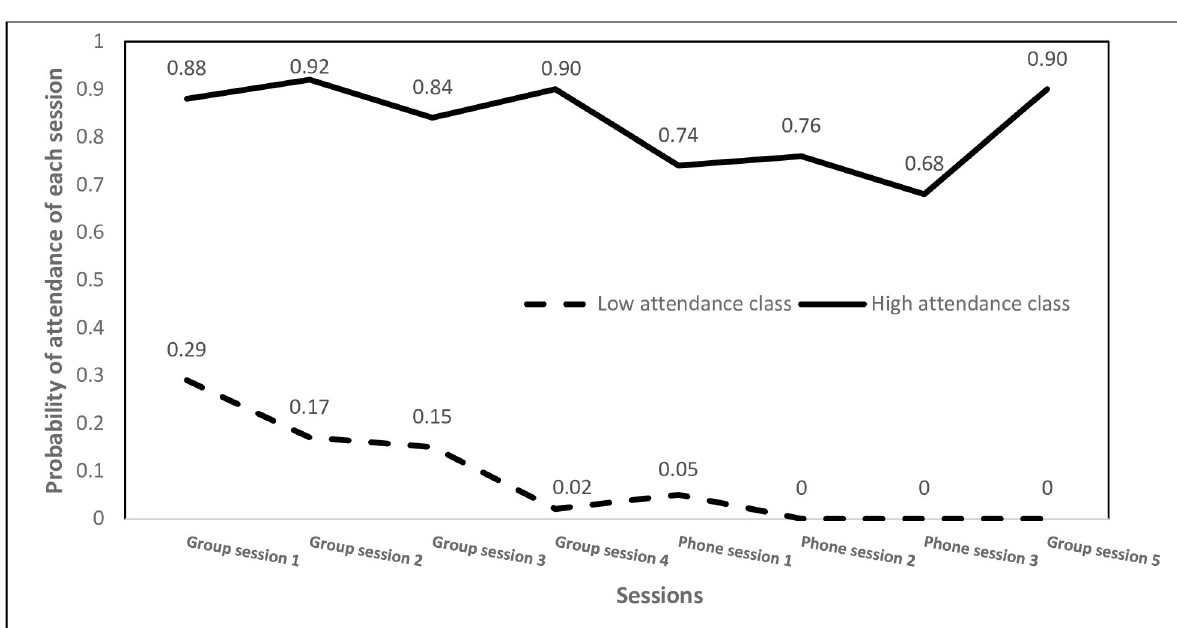
Fig 1. Probability of attendance for each session by latent class membership. Note: Group session 1 (introduction and car seat safety), group session 2 (poison hazard), group session 3 (fire prevention), group session 4 (fall prevention), group session 5 (review and celebration). The two lines indicate the observed probabilities of attendance of each session for “low attendance class” and “high attendance class”, separately.